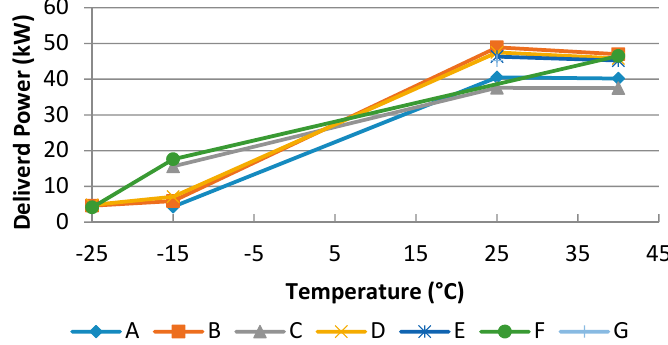
Figure 2. Delivered power as a function of the temperature.